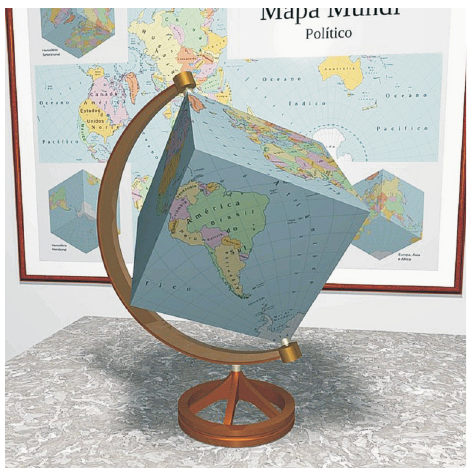
Fig. 12. The Earth in the form of a cube (www.progonos.com/furuti/MapProj/Dither/ProjPoly/ projPoly.html)